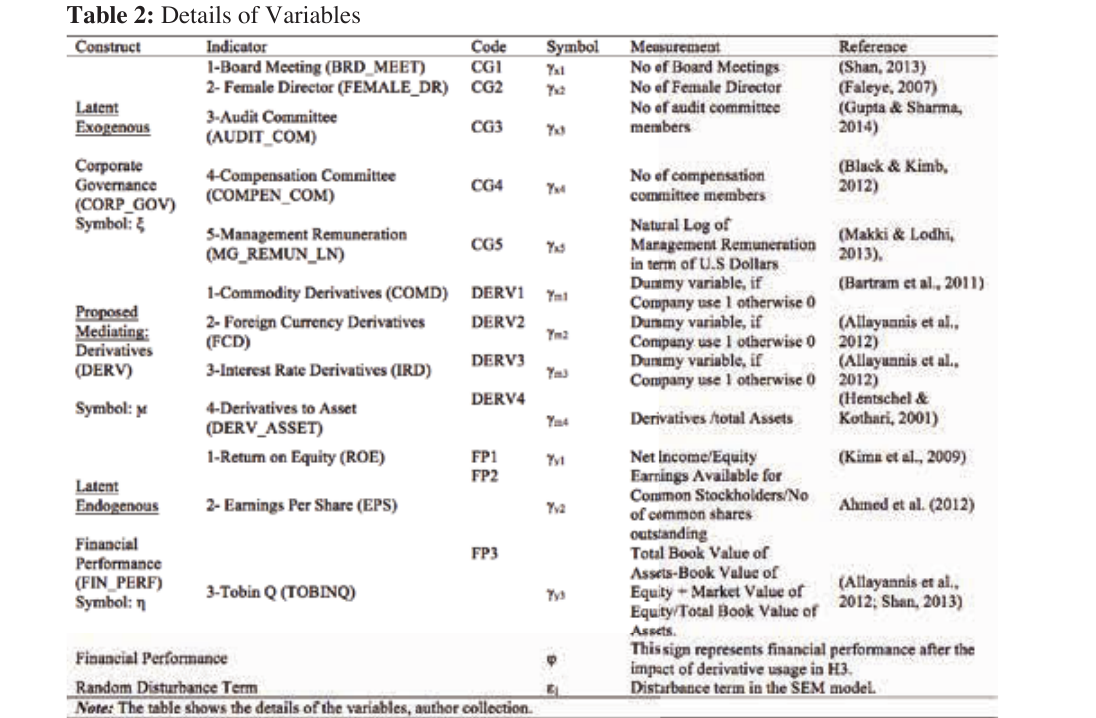
Table 2: Details of